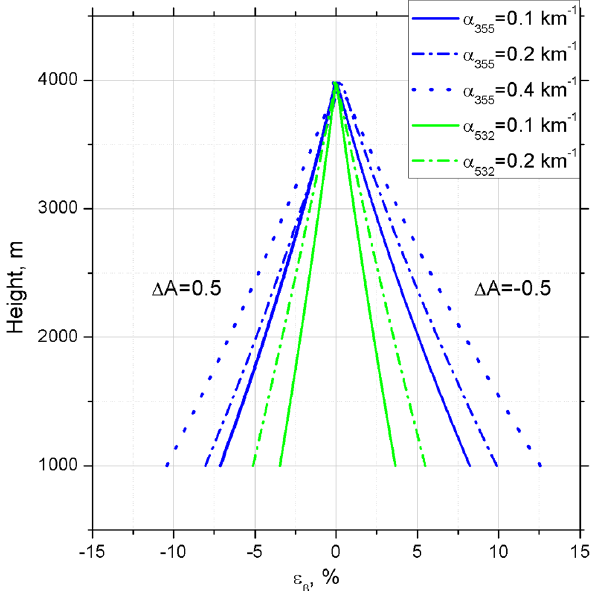
Figure 1. Profiles of backscattering coefficient uncertainties at 355 (blue) and 532nm (green) for extinction coefficient 0.1km − 1 (solid), 0.2km − 1 (dash-dot), 0.4km − 1 (dot) and (cid:49)A =± 0.5.